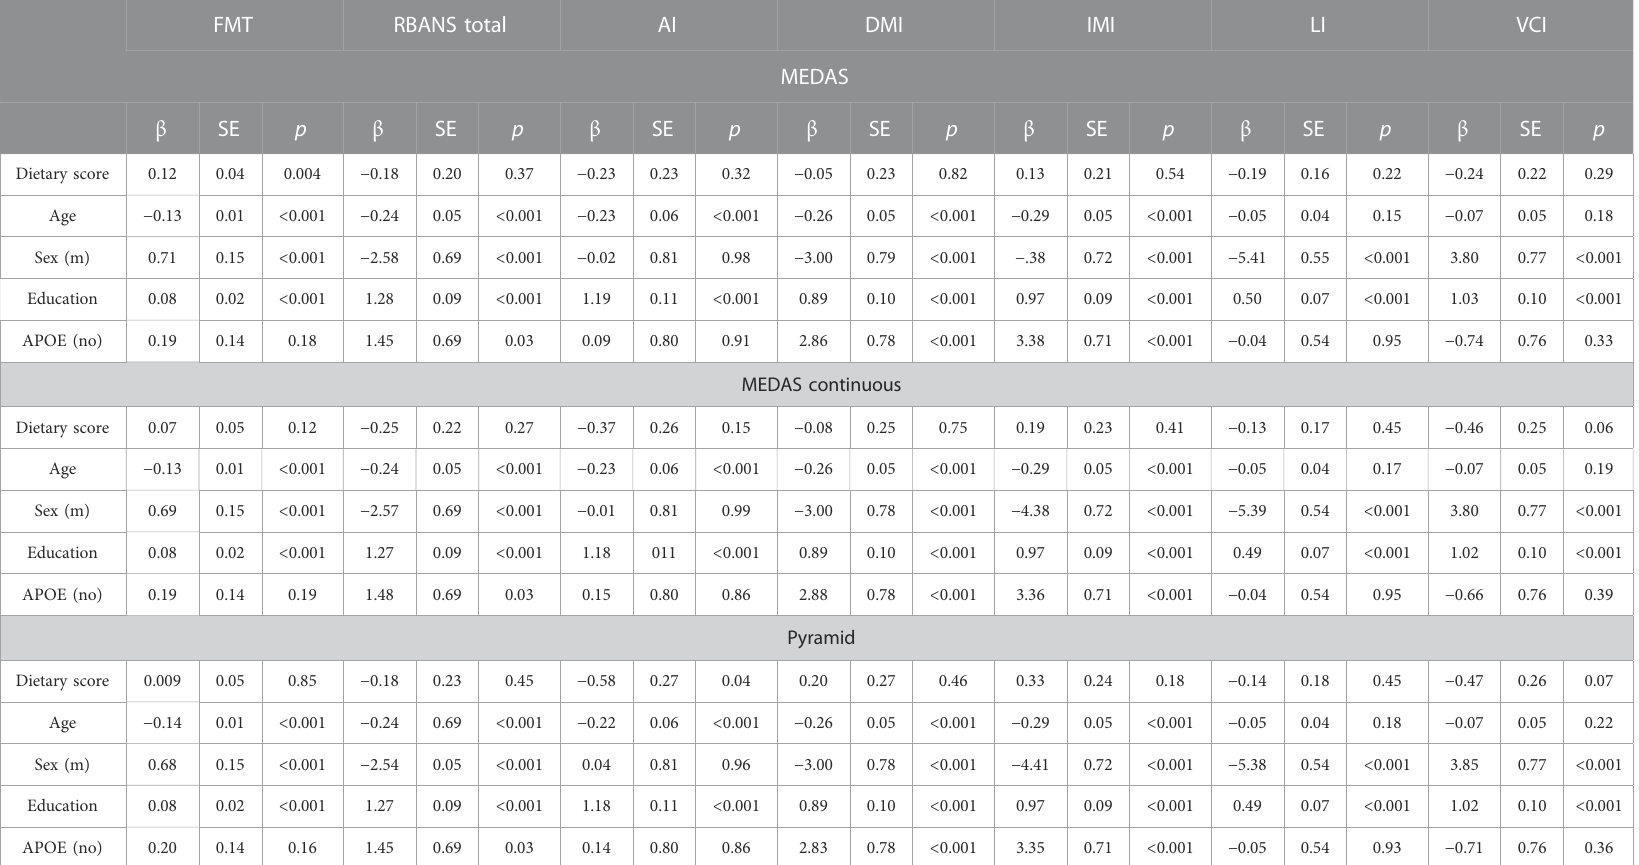
TABLE 2 Fully adjusted linear regression models of MedDiet scores (MEDAS, MEDAS Continuous and Pyramid) with cognitive outcomes, MedDiet score, sex, age, education and APOE shown. Fully Adjusted Model: MedDiet Score, sex, age, education, family history, APOE, physical activity, smoking, sleep, body mass index, hypertension, hypercholesterolemia, hyperglycaemia, diabetes, stroke, antihypertensive